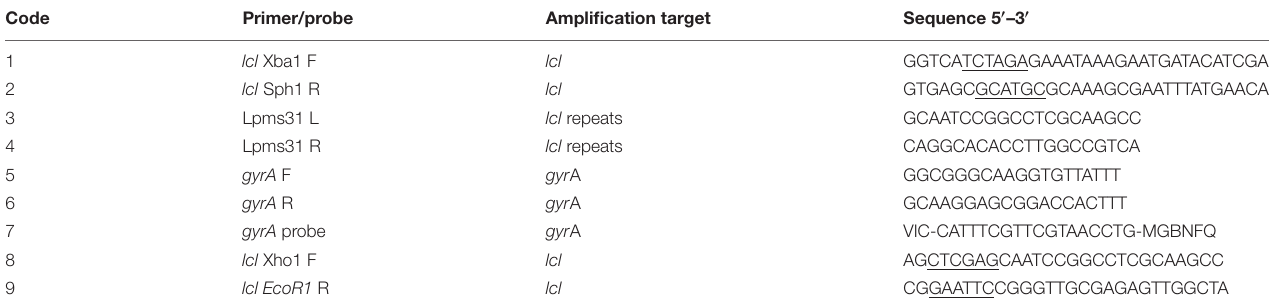
TABLE 3 | Primers and probes used in this